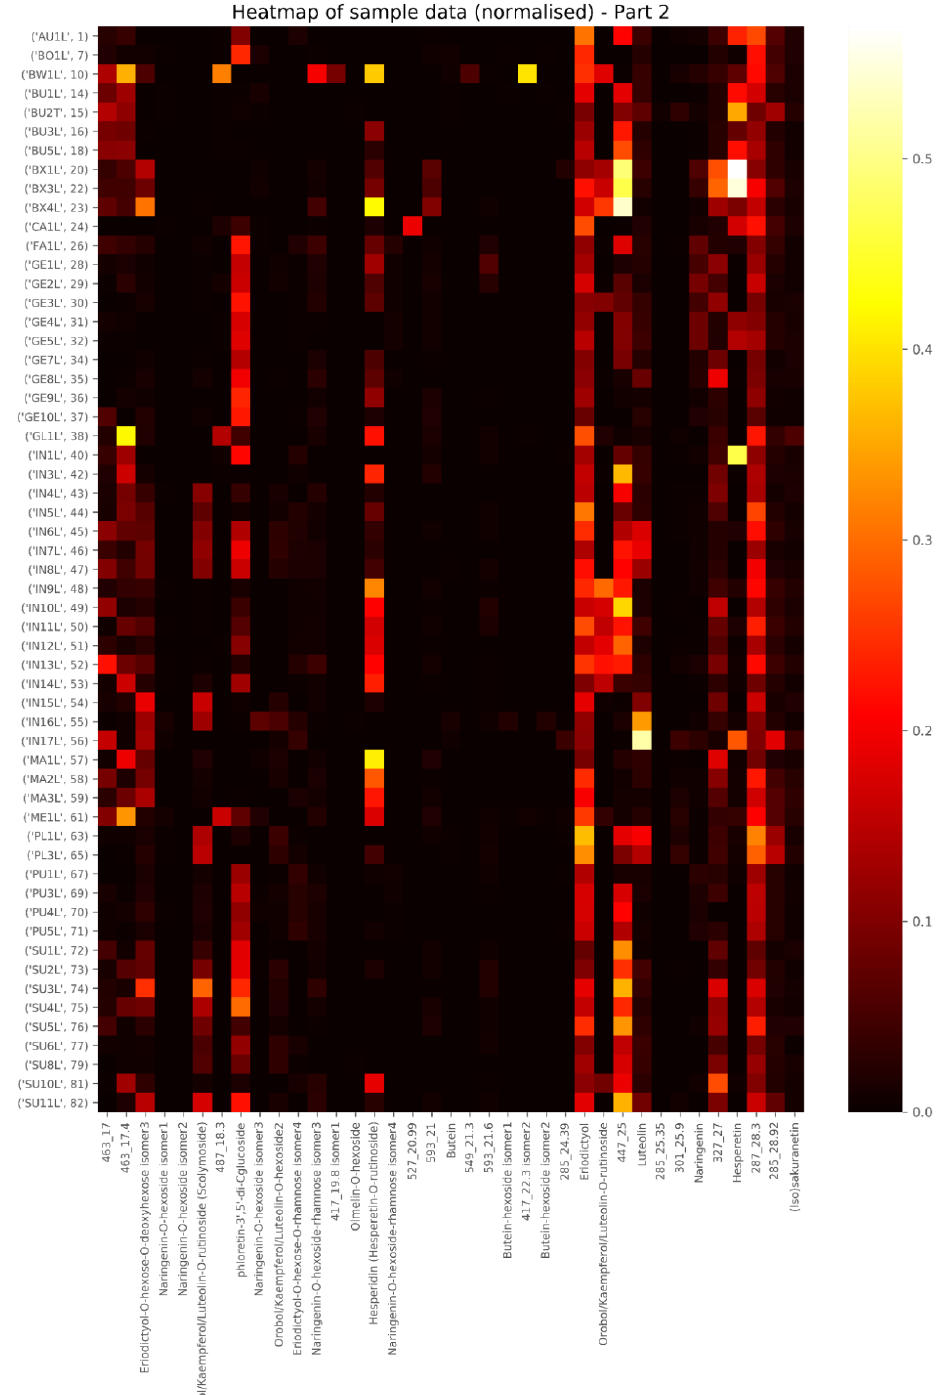
Figure 2. Heatmap of the main peaks detected in the Cyclopia extracts, showing mangiferin as the most abundant phenolic compound in most samples (light vertical line). The lighter the spot, the higher the concentration. C. aurescens (AU), C. bolusii (BO), C. bowiena (BW), C. burtonii (BU), C. buxifolia (BX), C. capensis (CA), C. falcata (FA), C. genistoides (GE), C. glabra (GL), C. intermedia (IN), C. maculata (MA), C. meyeriana (ME), C. plicata (PL), C. pubescens (PU) and C. subternata (SU); (L = leaves, T = twigs, P = pods, S = seeds); Sample numbering is according to sample locality from West to East per